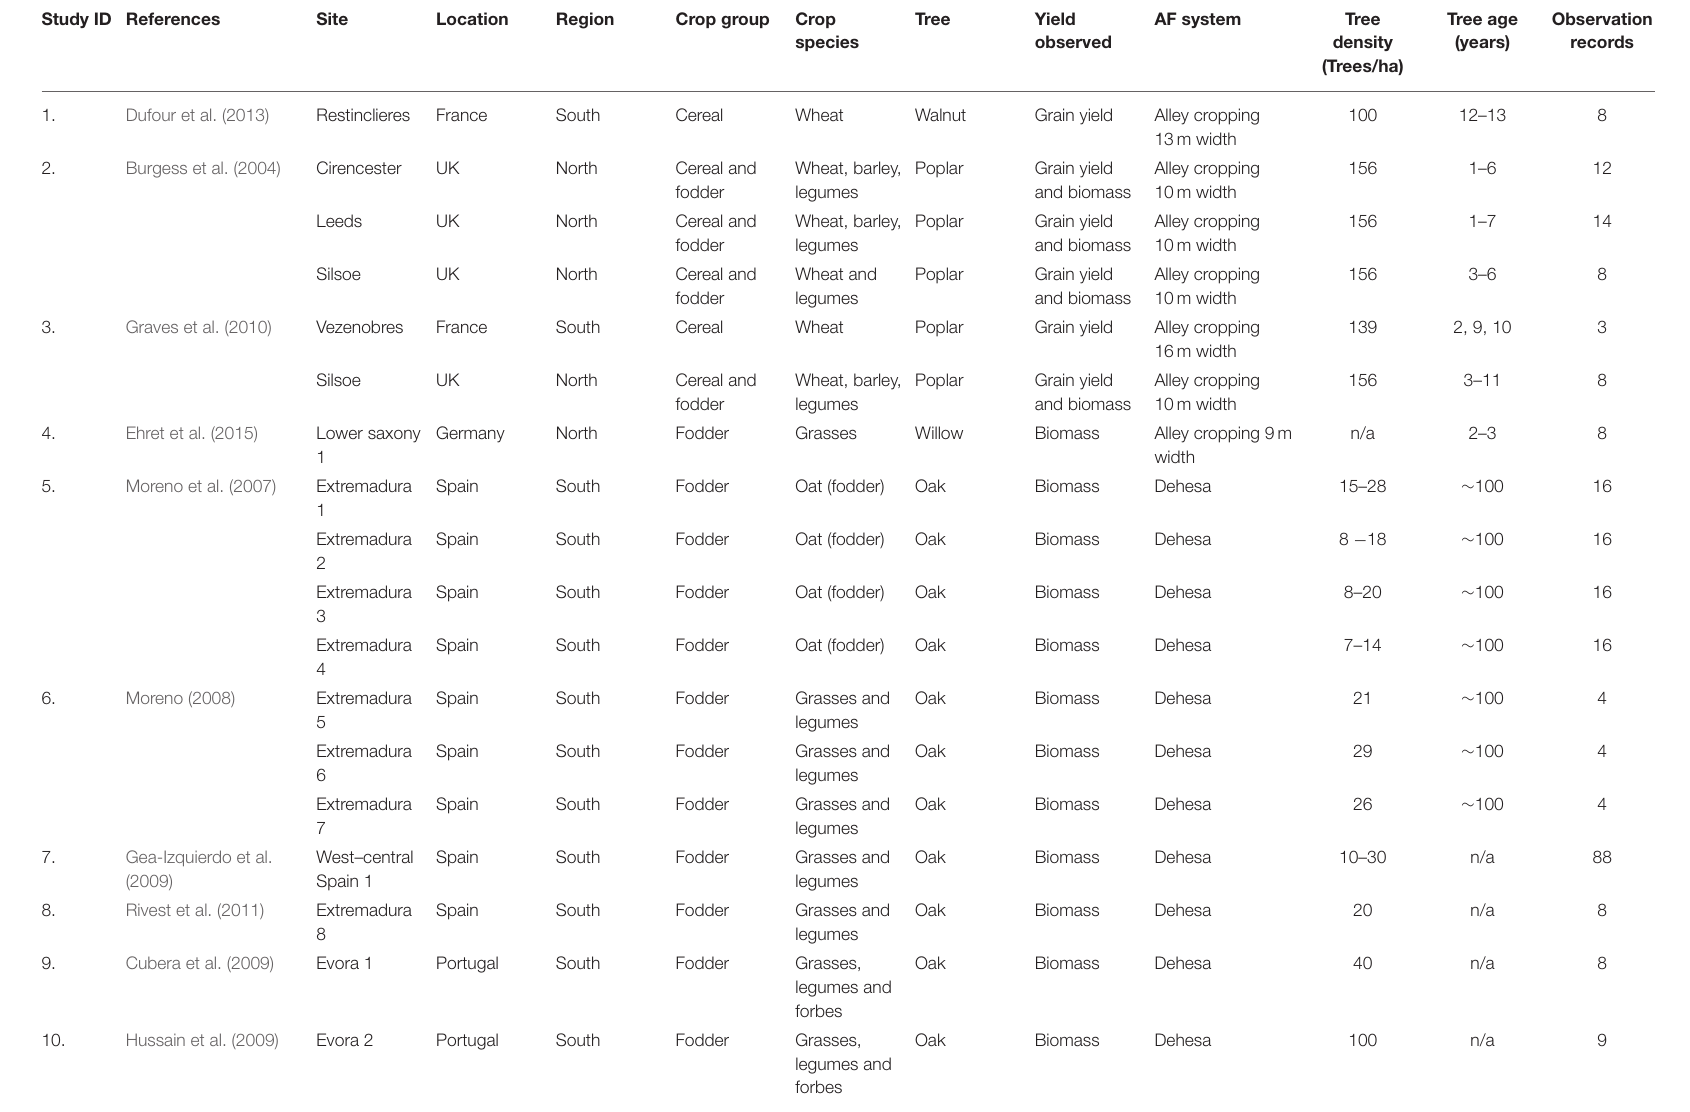
TABLE 1 | Main characteristics of the studies included in the